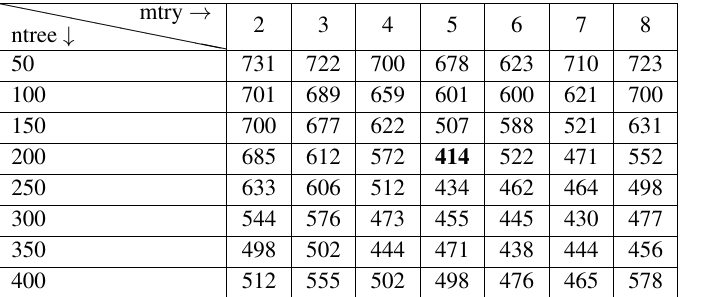
Table 4. Performance of SVR in terms of R 2